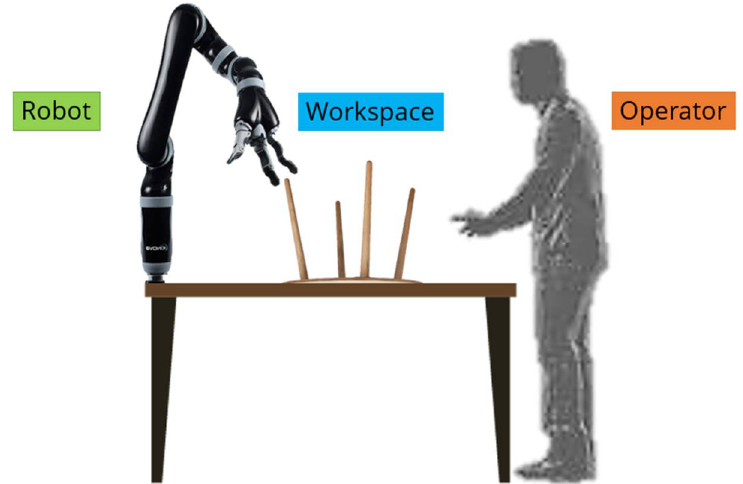
Figure 2. Human–Robot Collaboration—Case Study: Wood-Chair Assembly.